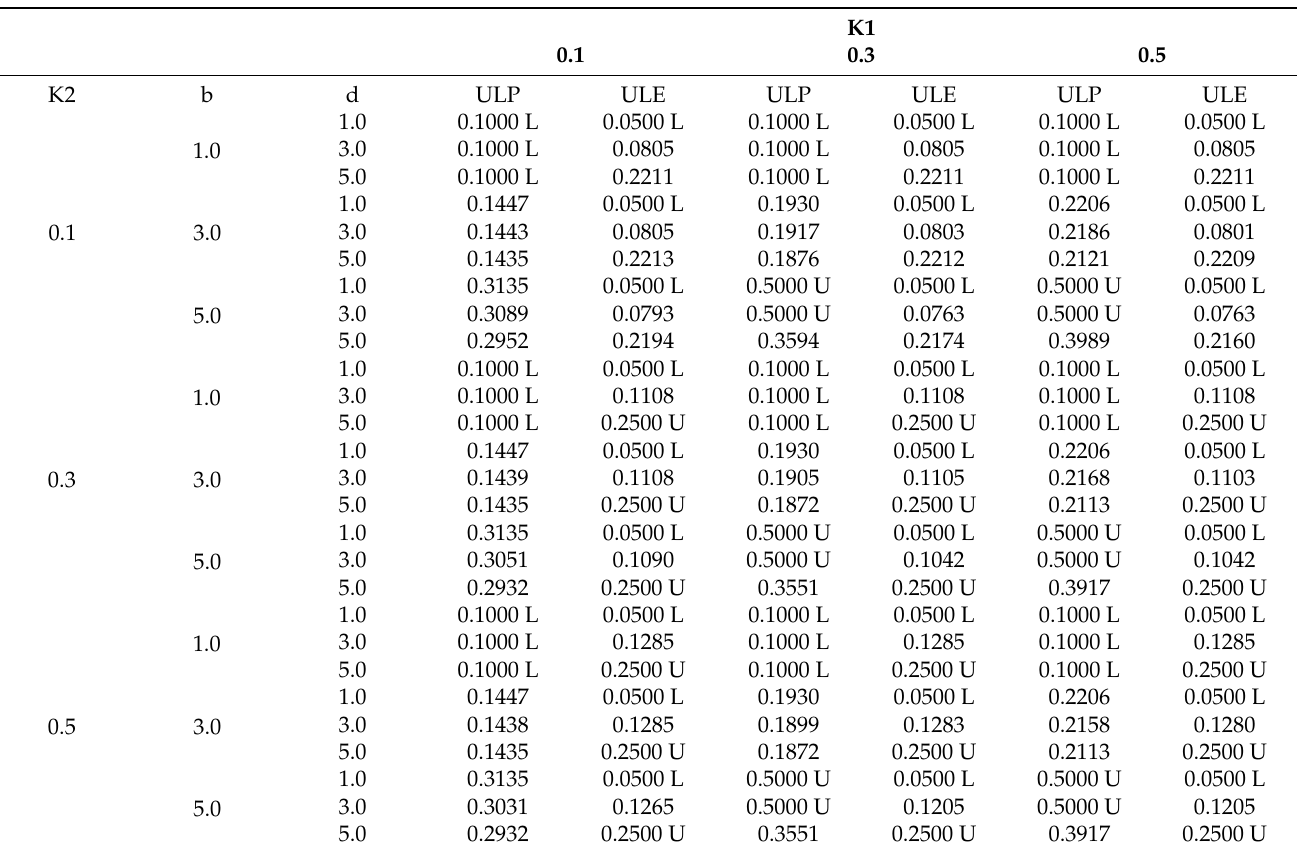
Table 16. Grid Analysis for Optimal ULP and ULE—L2